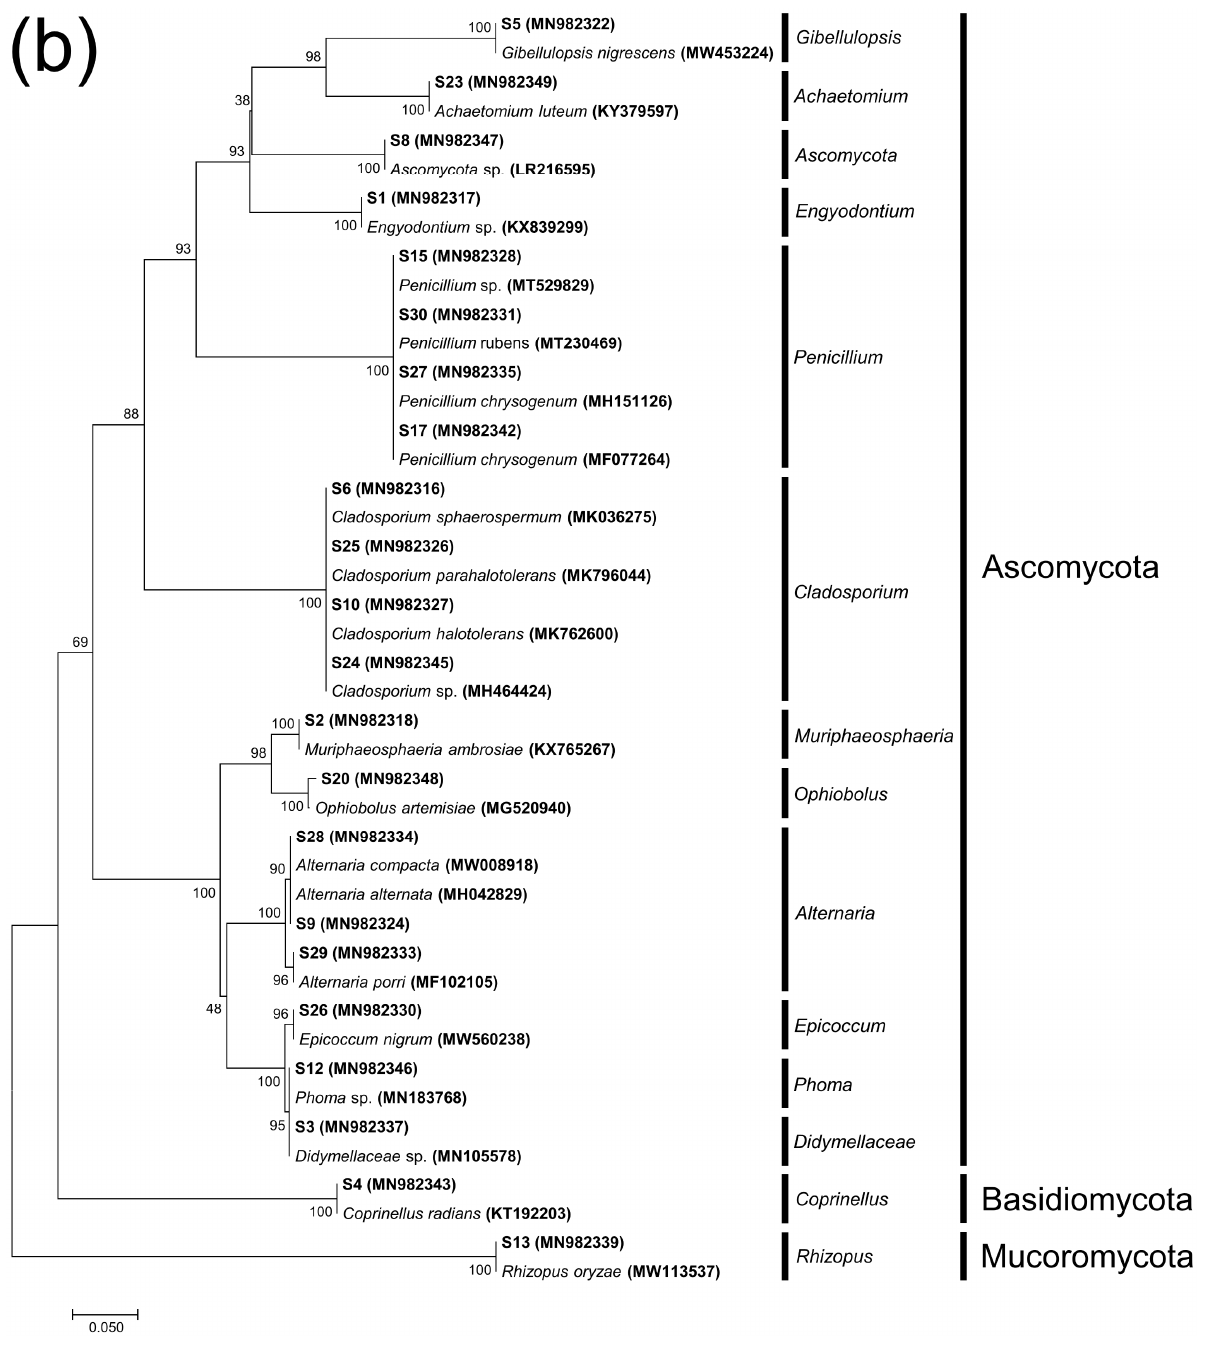
Figure 4. Neighbor-joining tree representing strains of bacteria ( a ) and fungi ( b ) isolated from samples based on the 16S rRNA gene sequences and the ITS gene sequences, respectively.